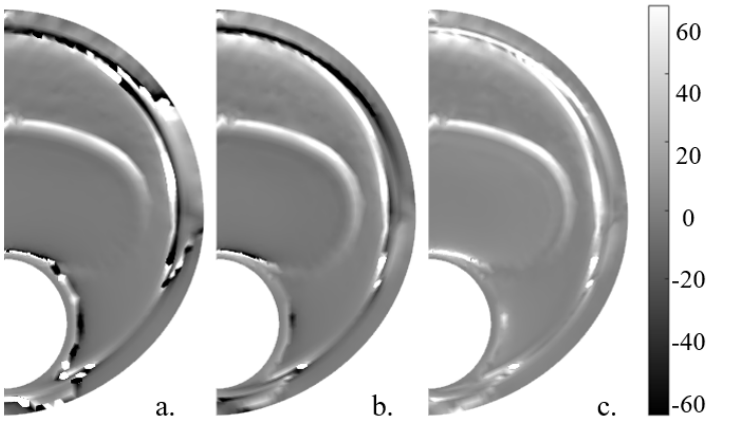
Figure 9. Idealized geometry with 150 µ m thickness with the different dW represented without noise. ( a ) dW simplified , ( b ) dW computed with the 2D strain tensor, and ( c ) | dW |